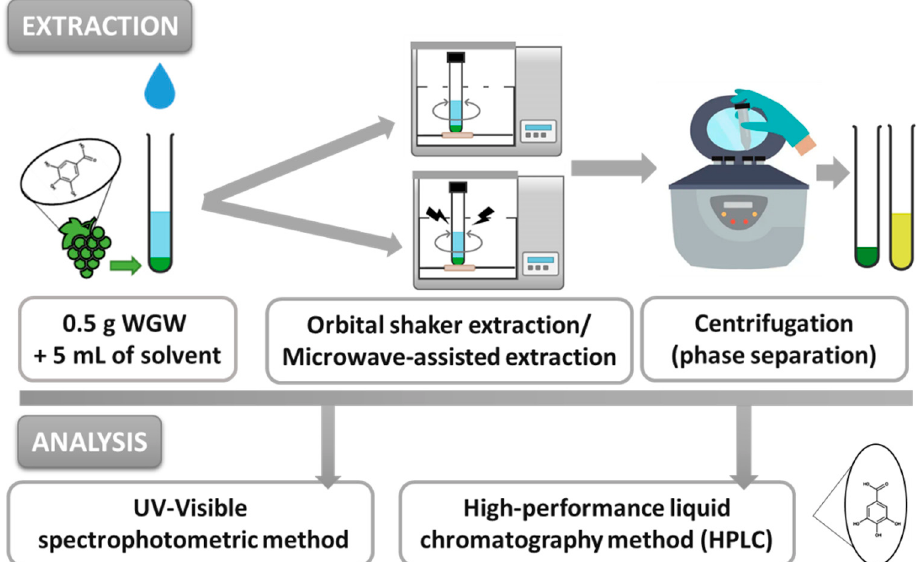
Figure 8. Global procedure: methods of extraction and analysis of phenolic compounds from white grape waste (WGW) by evaluating conventional solvents and NAESs as extraction agents.